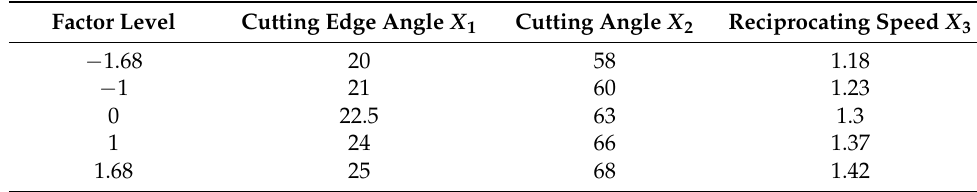
Table 4. Central composite design factor